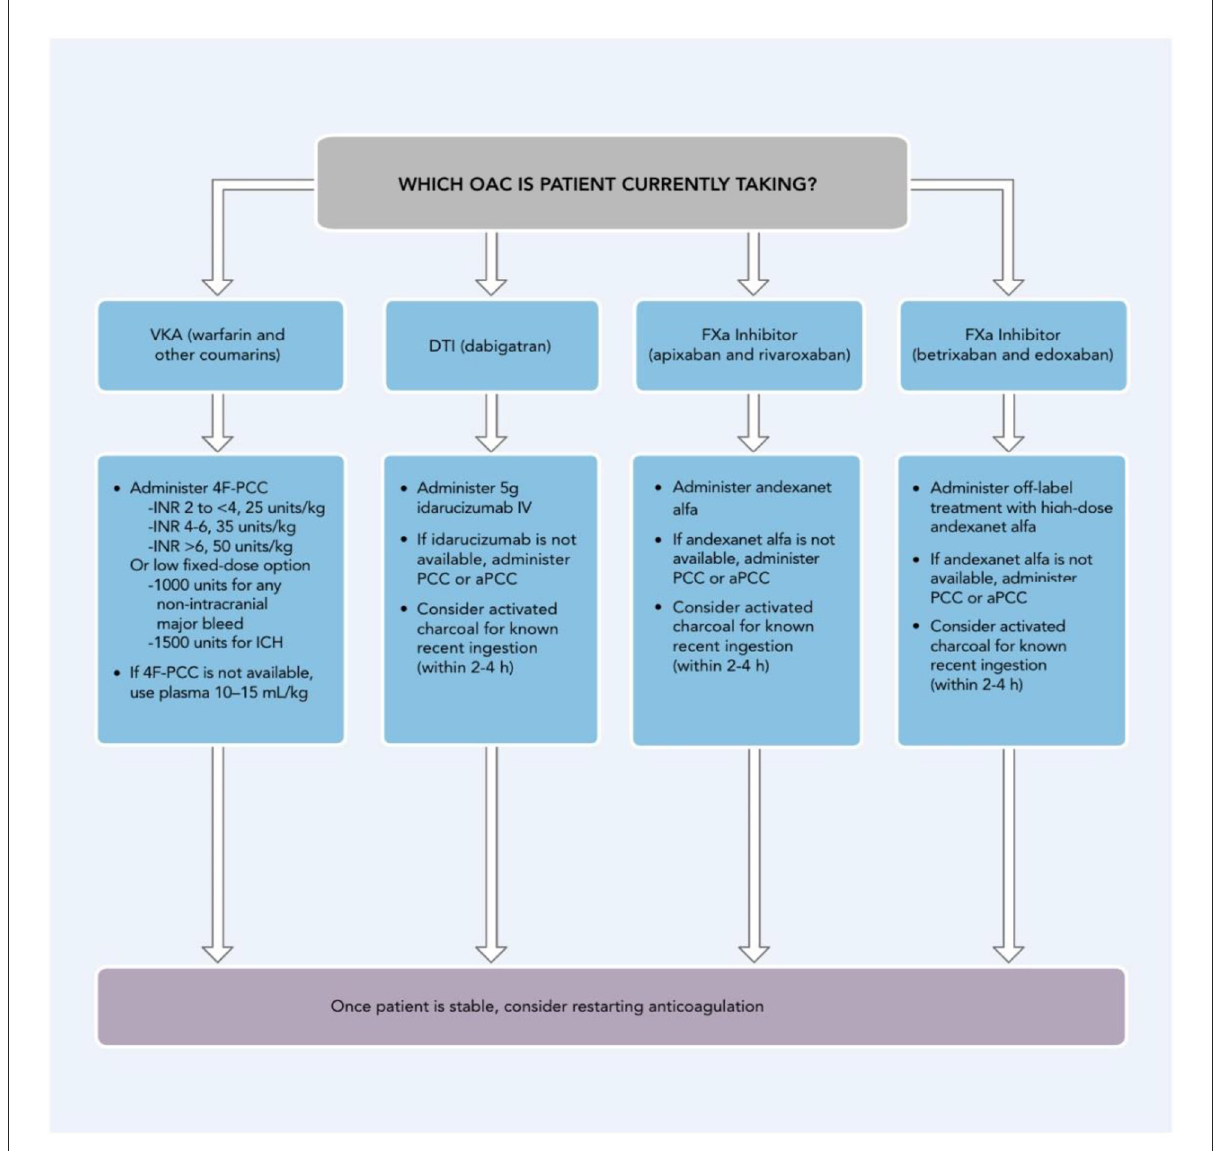
FIGURE1 Considerations for Reversal/Hemostatic agents * . 4F-PCC, four-factor prothrombin complex concentrate; aPCC, activated prothrombin complex concentrate; DOAC, direct-acting oral anticoagulant; DTI, direct thrombin inhibitor; FXa, Factor Xa; h, hours; ICH, intracranial hemorrhage; INR, international normalized ratio; IV, intravenous; OAC, oral anticoagulant, including DOACs and VKAs; PCC, prothrombin complex concentrate; VKA, vitamin K antagonist; * Reversal/hemostatic agents include repletion strategies such as PCCs, plasma, vitamin K, and specific reversal agents for DOACs (e.g., idarucizumab for dabigatran; andexanet alfa for apixaban or rivaroxaban). † When PCCs are used to reverse VKAs, vitamin K should also always be given. Adapted from Tomaselli et al. (160) with